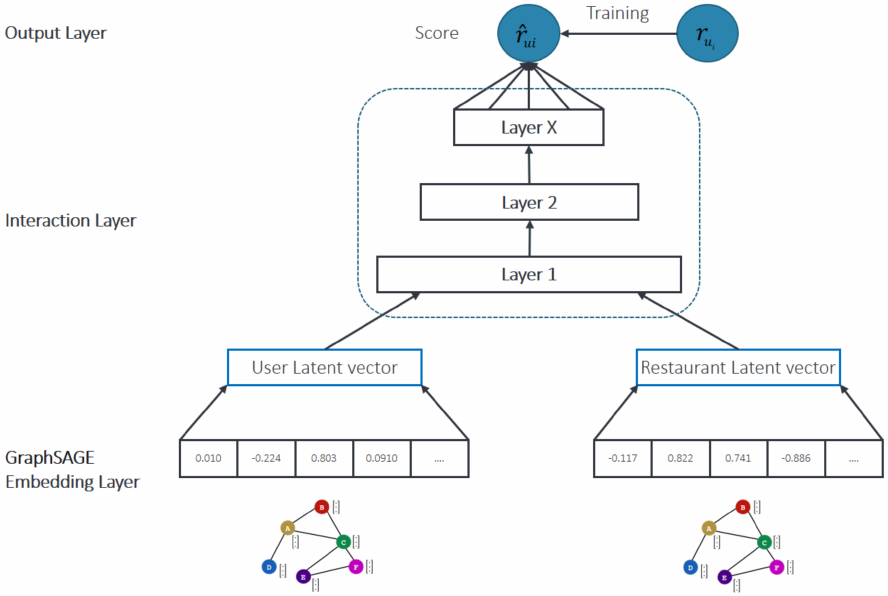
Figure 6. NCF-based re-rank